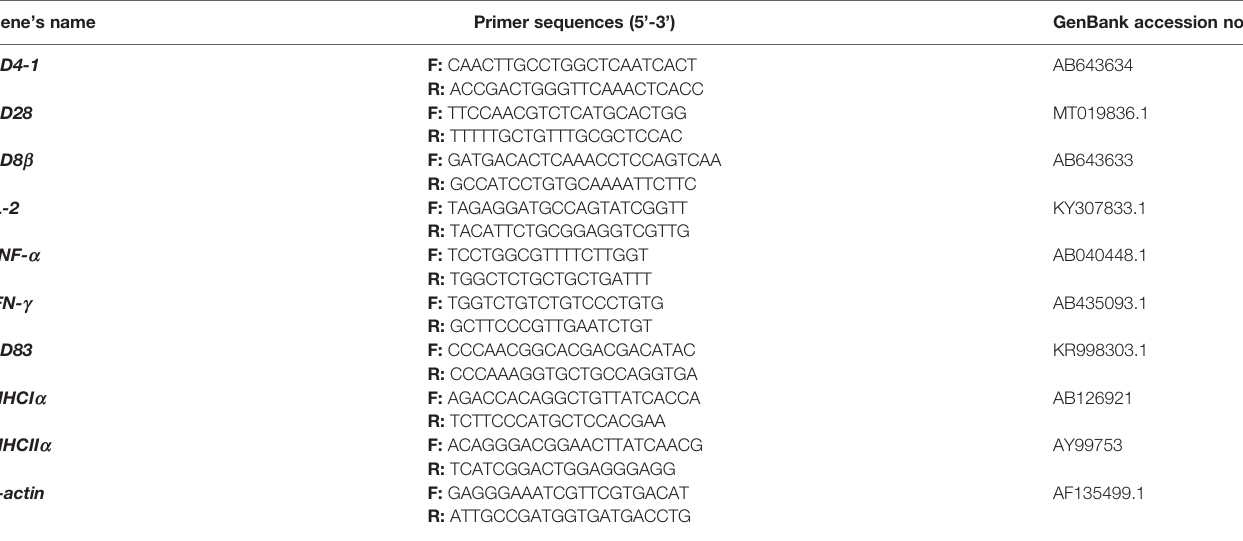
TABLE 3 | Sequences of primers used for